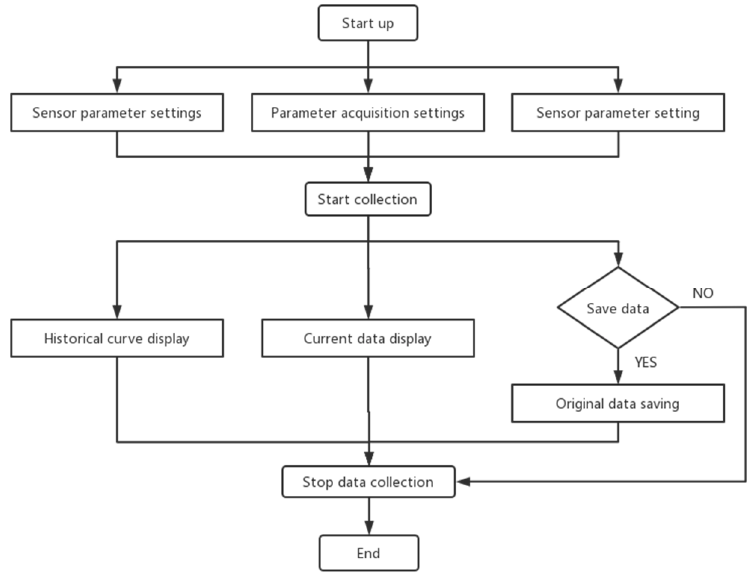
Figure 4. Flow chart of measurement system software.